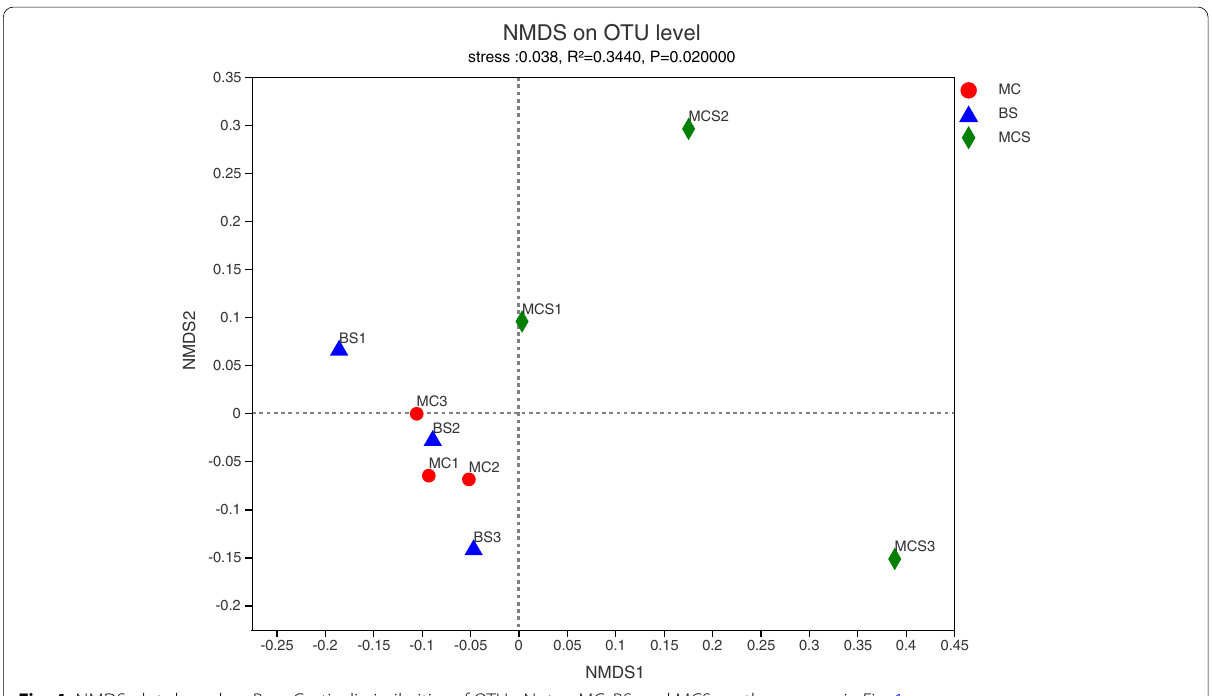
Fig. 4 NMDS plots based on Bray‑Curtis dissimilarities of OTUs. Notes: MC, BS, and MCS are the same as in Fig. 1